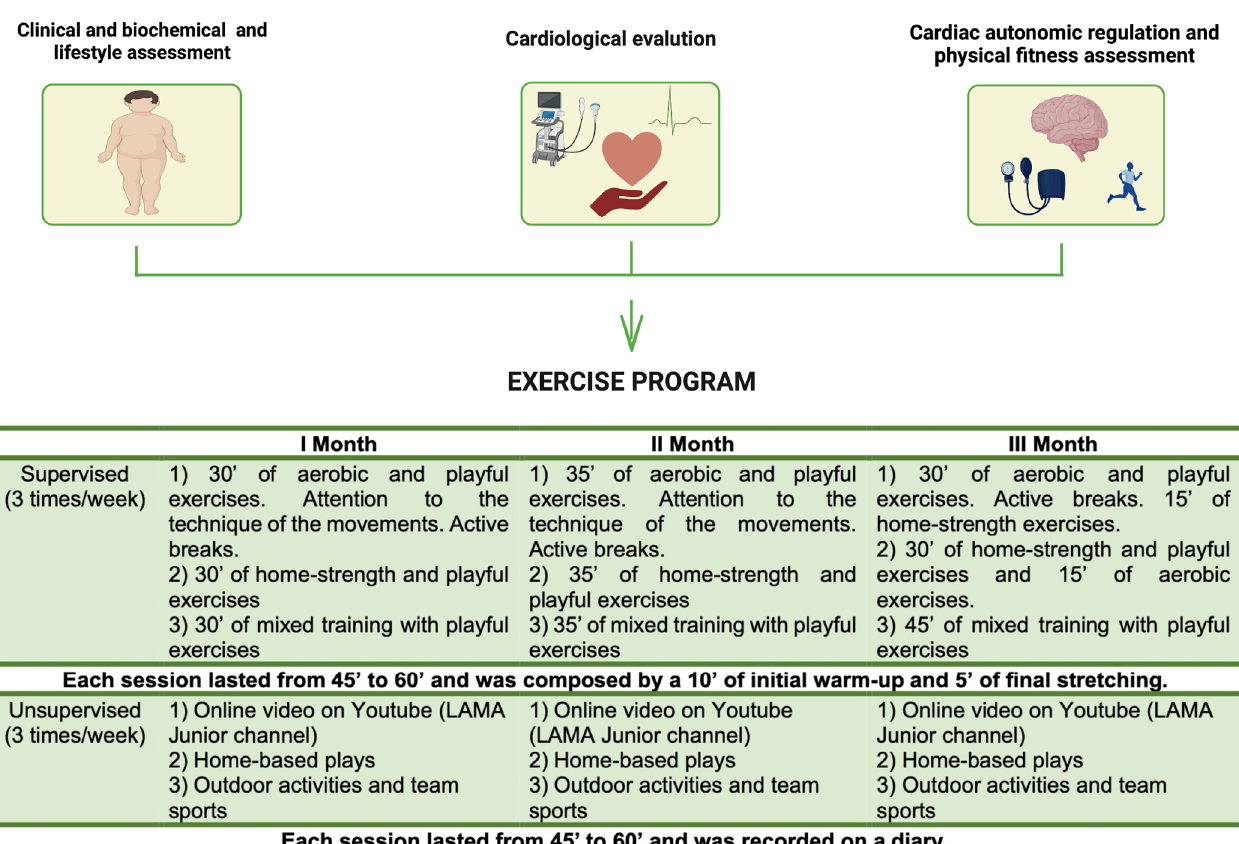
Figure 1. Exercise program